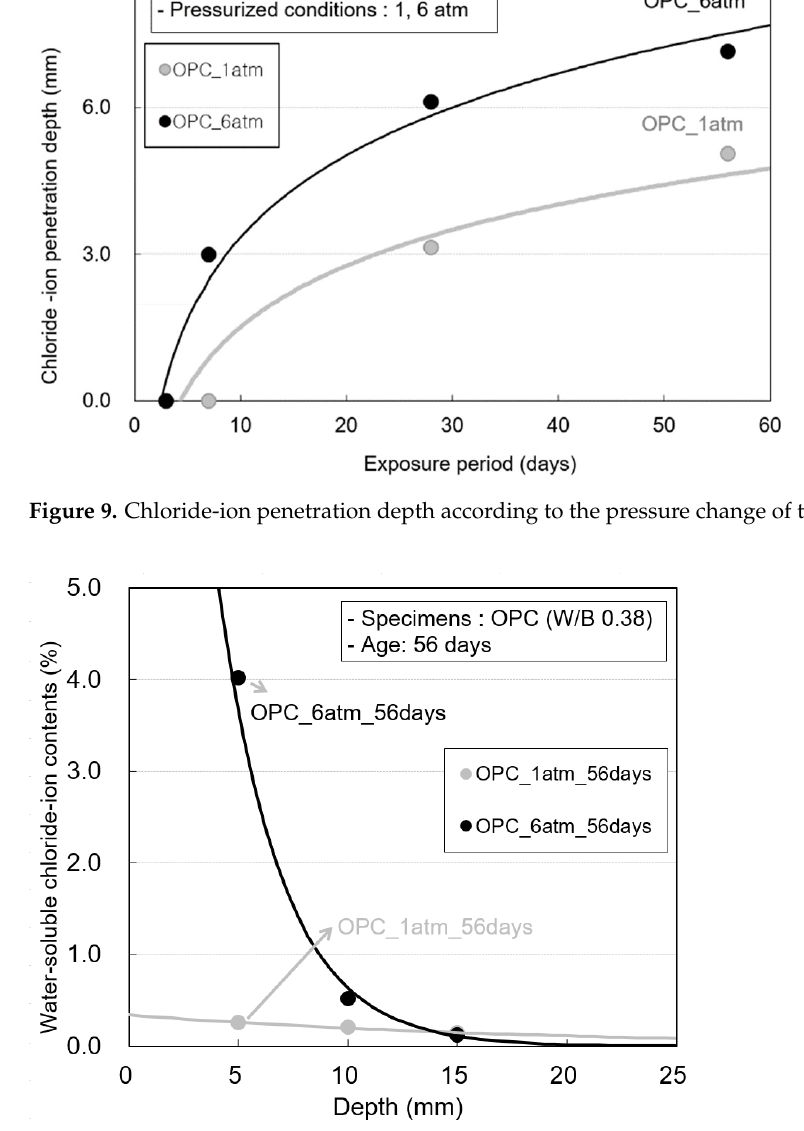
Figure 10. Water-soluble chloride-ion contents according to the pressure change of the OPC specimen.